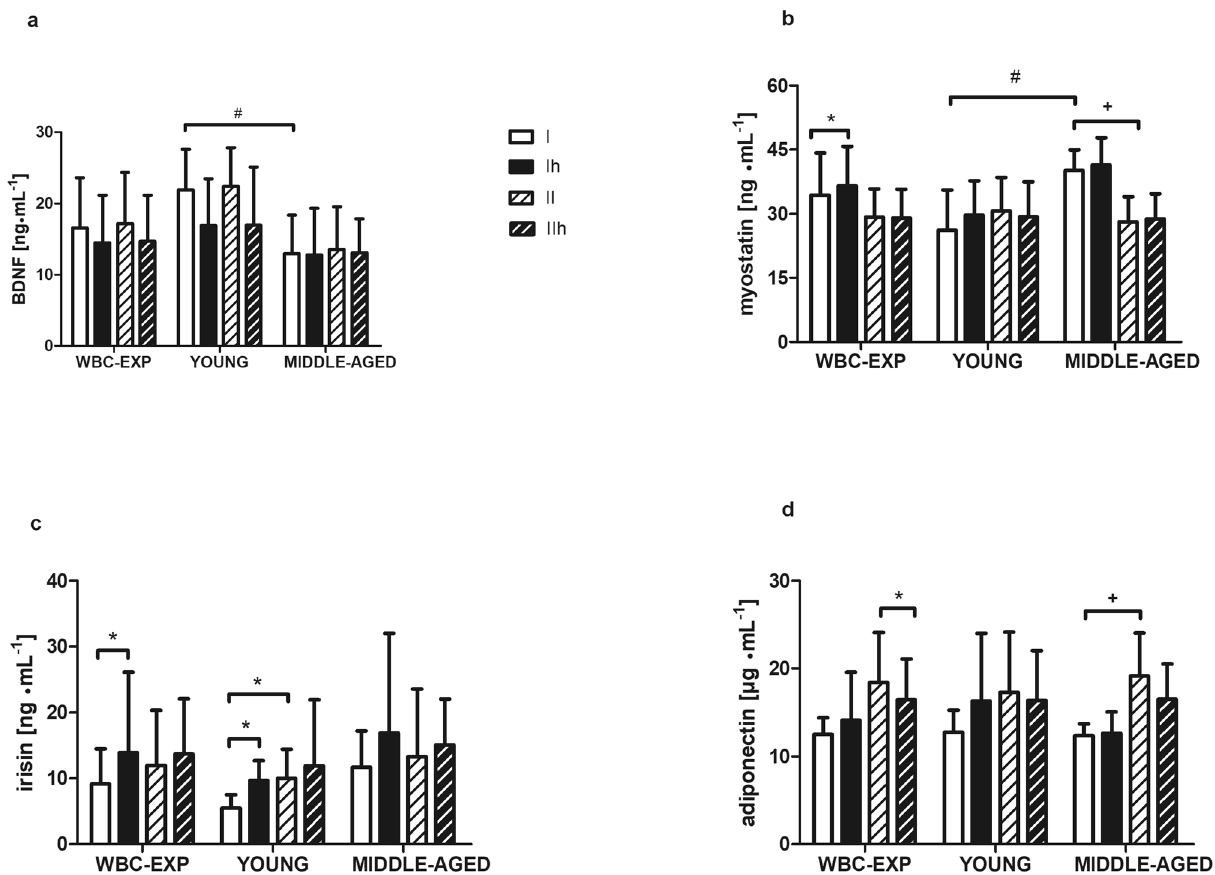
Figure 1. Group- and age-related changes post a single session of the WBC in concentrations of ( a ) BDNF; ( b ) myostatin; ( c ) irisin and ( d ) adiponectin; recorded before (I) and 1 h after the first (Ih) as well as before (II) and 1 h after the last (IIh) WBC session. WBC-EXP (n = 22) included young (YG, n = 9) and middle aged (MG, n = 13) participants. Data are presented as mean ± SD; *statistical significance in the group; #statistical difference between groups at a time point, + statistical significance in the group MG vs WBC-CON.